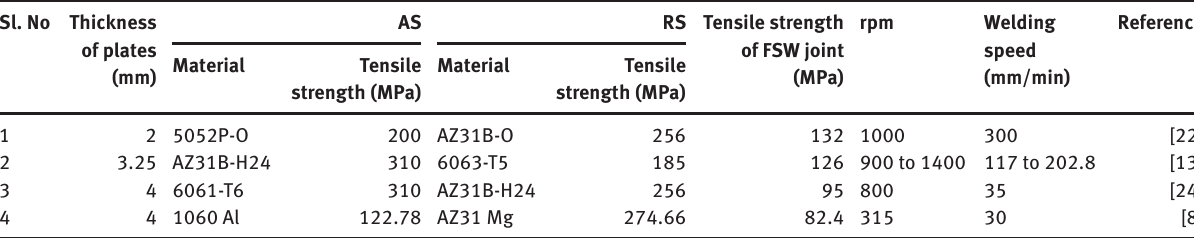
Table 2: Strength of welds of dissimilar materials FSW. Sl. No Thickness